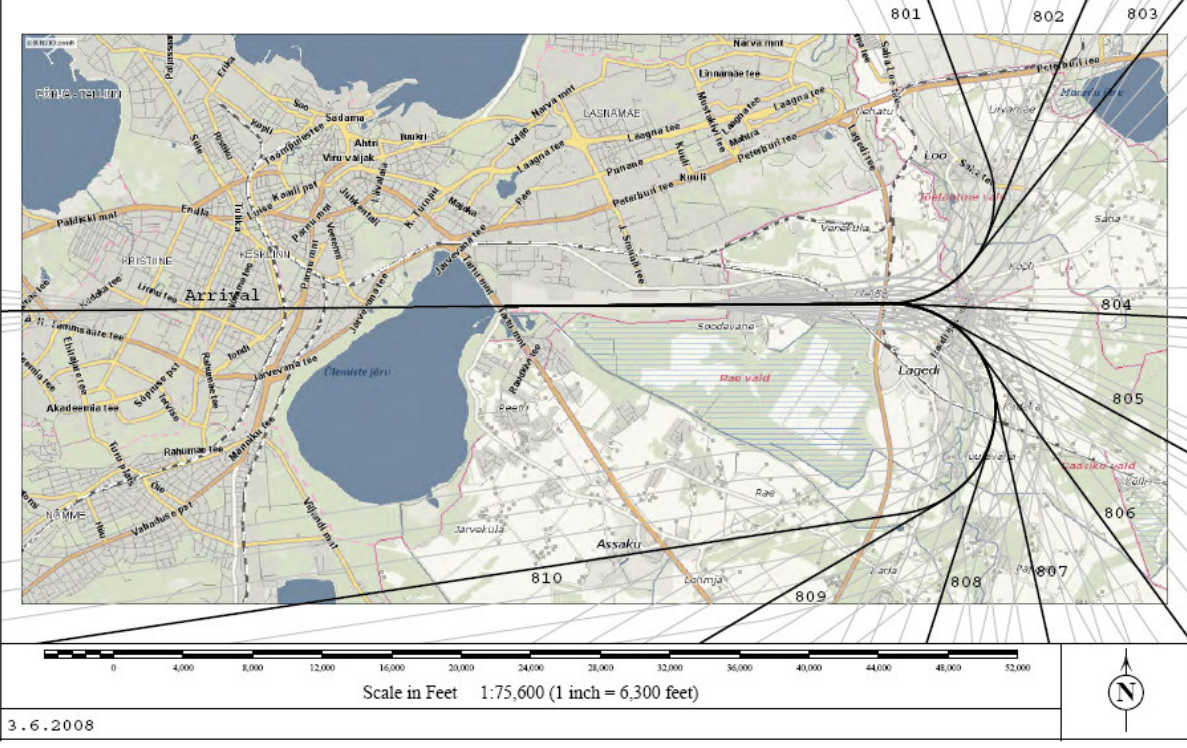
Fig 2. Tallinn Airport. Noise map according to Directive 2002/49/EC. Air corridors of runway